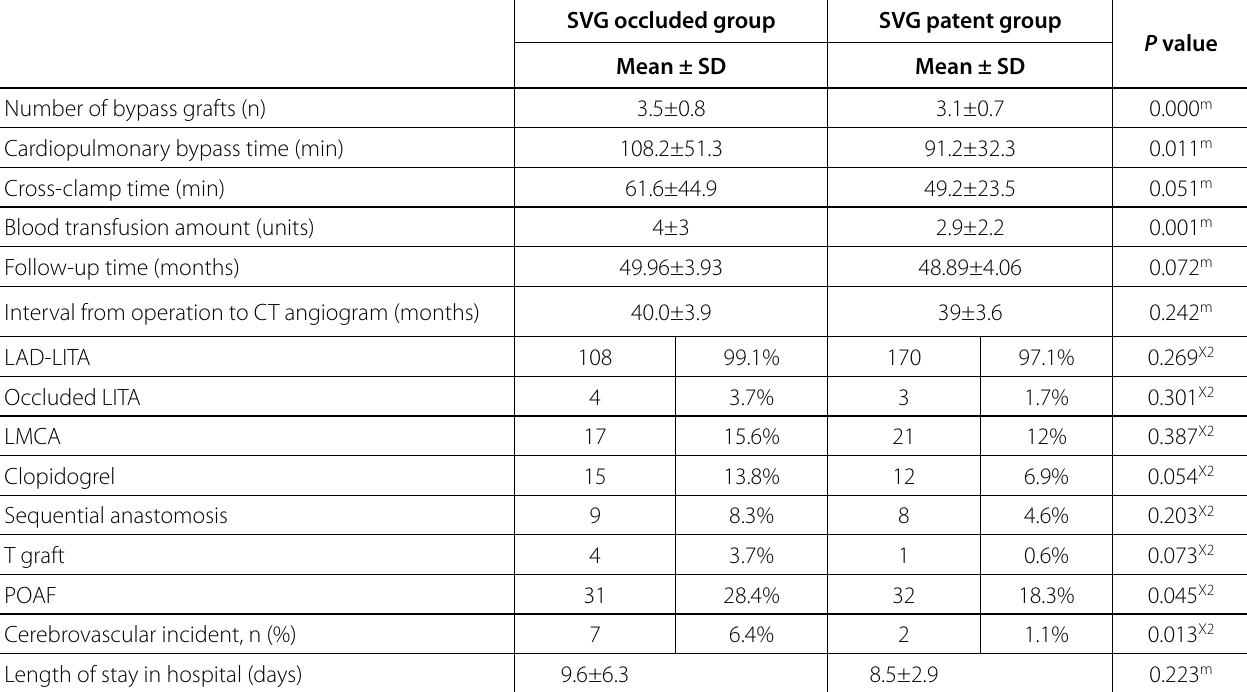
Table 3 . Operative and postoperative